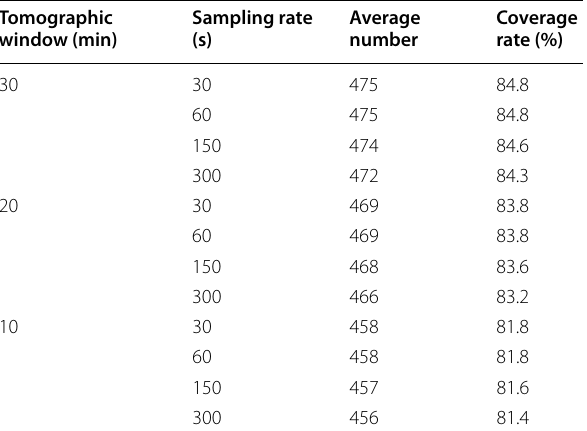
Table 1 Statistics of the voxels crossed by signal rays for each scheme